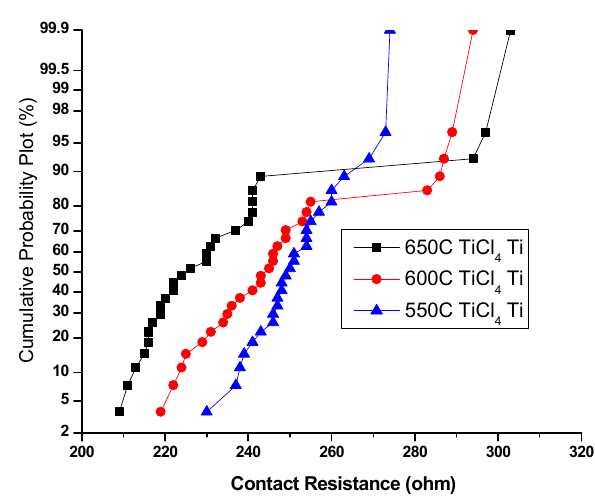
Figure 4. Cumulative probability plot of contact resistance for PECVD TiCl 4 -based Ti at different process temperatures.